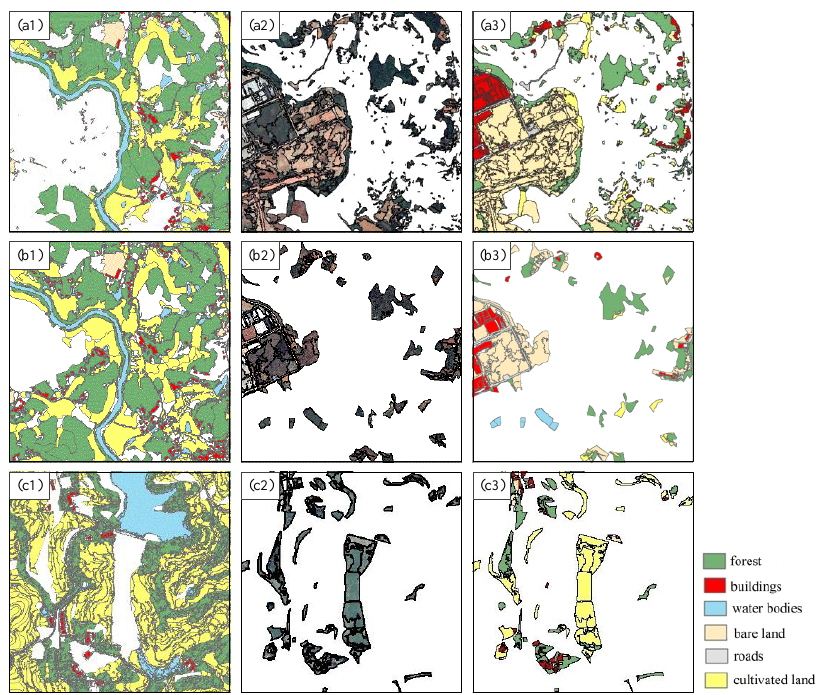
Figure 9. The results of change detection based on the proposed method. ( a1 – a3 ) are the results of changed object detection, resegmentation, and classification of changed image objects in experiment one, respectively; ( b1 – b3 ) are the results of changed object detection, resegmentation, and classification of changed image objects in experiment two, respectively; ( c1 – c3 ) are the results of changed object detection, resegmentation, and classification of changed image objects in experiment three, respectively. Table 5. Change matrix of six types of surface objects from 2009 to 2017 in experiment one in the study area A. Types in 2017 (m 2 )